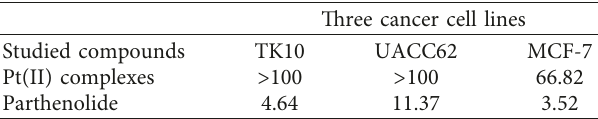
Table 2: Comparison of studied Pt(II) complex and parthenolide against three cancer cell lines in μ